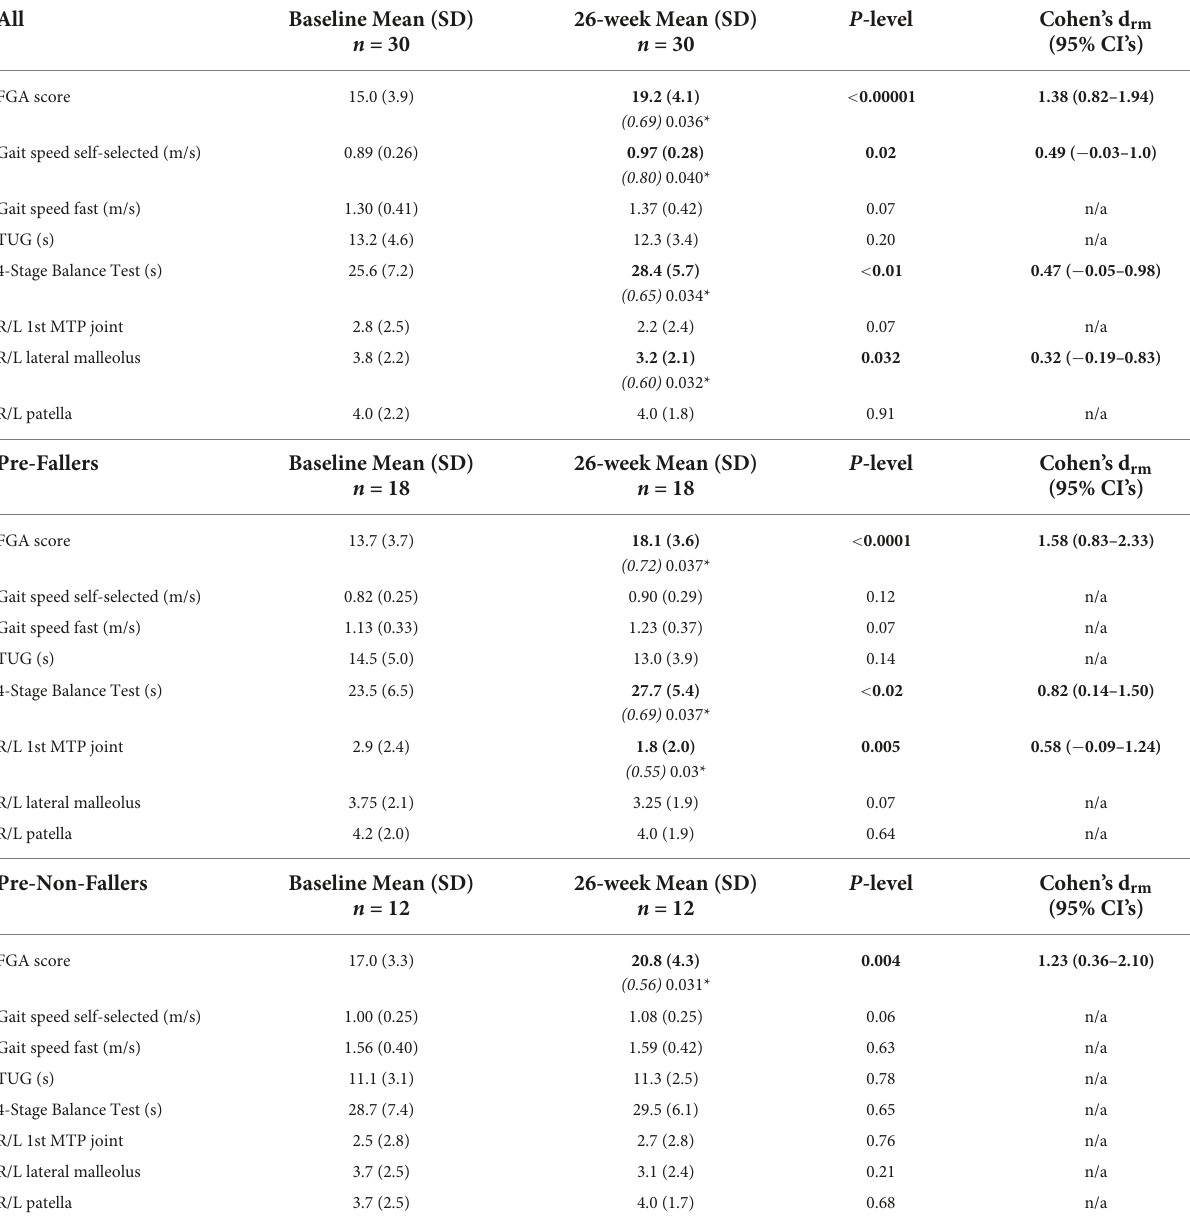
TABLE 3 Clinical outcomes and Rydel-Seiffer vibration sensation screening for the 30 individuals who were able to complete all in-person assessments at baseline and after 26 weeks as well as the subgroups of Pre-Fallers and Pre-Non-Fallers.